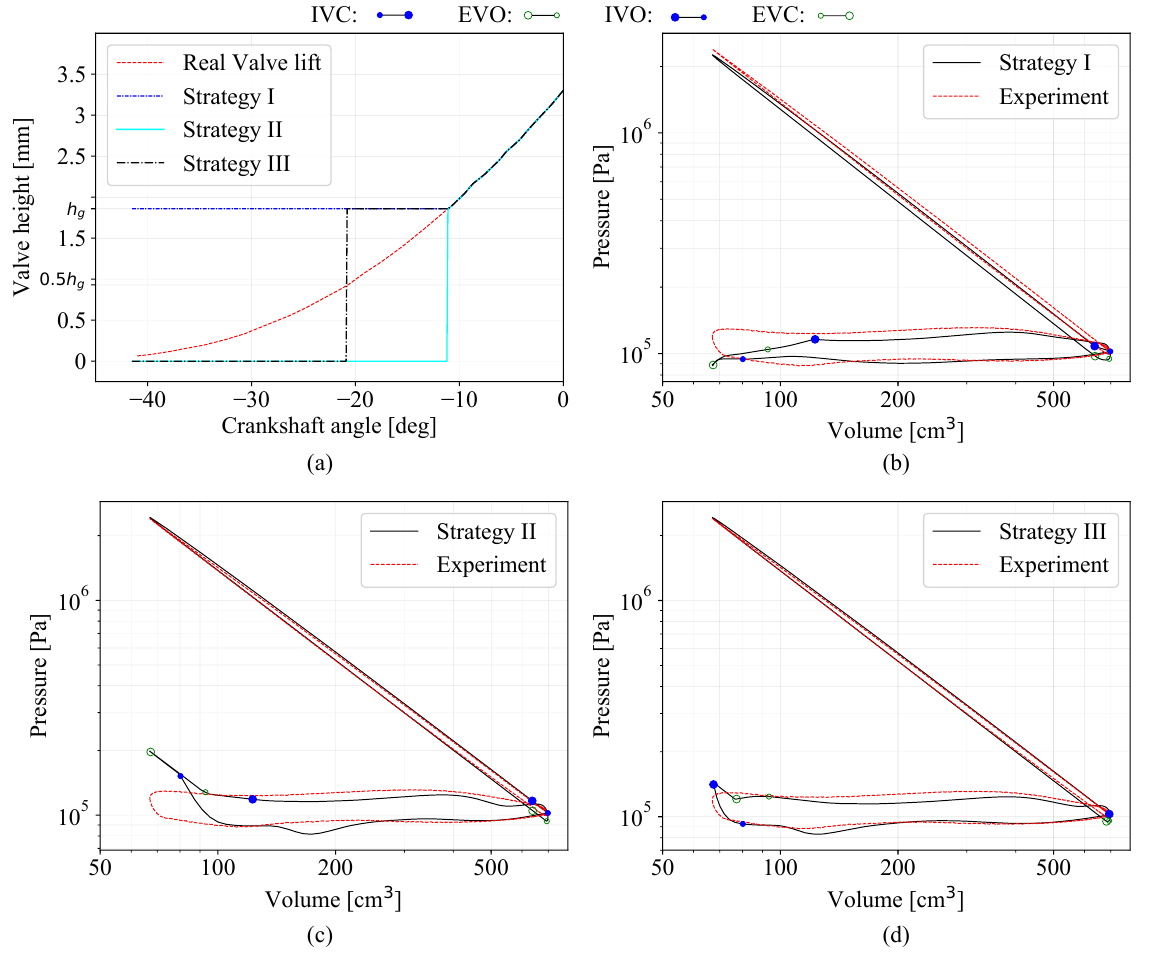
Figure 10. Valve height over time and cylinder pressure results for different attach-detach strategies: ( a ) valve height over time ; ( b ) strategy I; ( c ) strategy II; ( d ) strategy